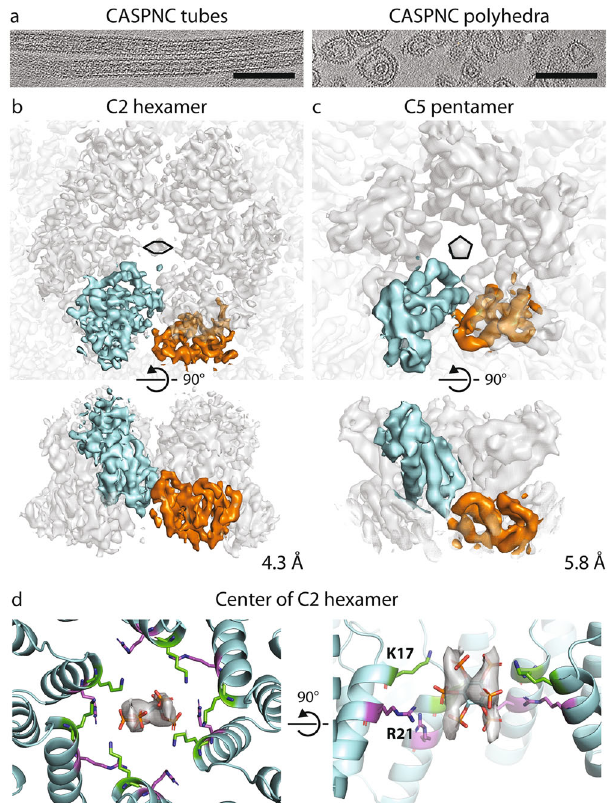
Fig. 2 Cryo-electron tomography of RSV CASPNC CLPs assembled in the presence of IP6. a Sum of ten computational slices through a gaussian- fi ltered tomogram containing CASPNC tubes and CASPNC polyhedrons. Scale bar is 100 nm. The slices are representative of the 49 tomogram dataset. b , c Isosurface representation of the subtomogram average of a C 2-symmetric CA hexamer from the CASPNC tubes ( b ) and a C 5- symmetric pentamer from CASPNC polyhedrons ( c ). In both cases, the CA NTD and CA CTD of one CA monomer are colored cyan and orange, respectively. The C 2 and C 5 symmetry of the hexamer and pentamer are annotated by a distorted schematic hexamer and a pentamer, respectively. The resolution of the individual structures is annotated. See corresponding FSC curves in Supplementary Fig. 3a. d Model of the IP6 binding site in the CA-NTD hexamer pore formed by amino acids K17 (green) and R21 (purple), as seen from the outside of the CLP (left) and rotated by 90° (right). The side chains are shown with their most likely rotamer position in agreement with the EM